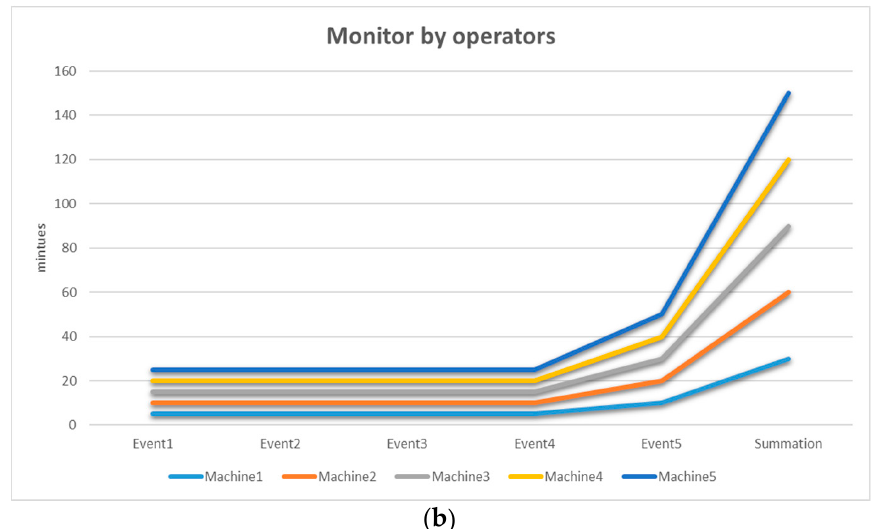
Figure 13. ( a ) The waiting time is caused by the VDR system; ( b ) the waiting time is caused by operators.